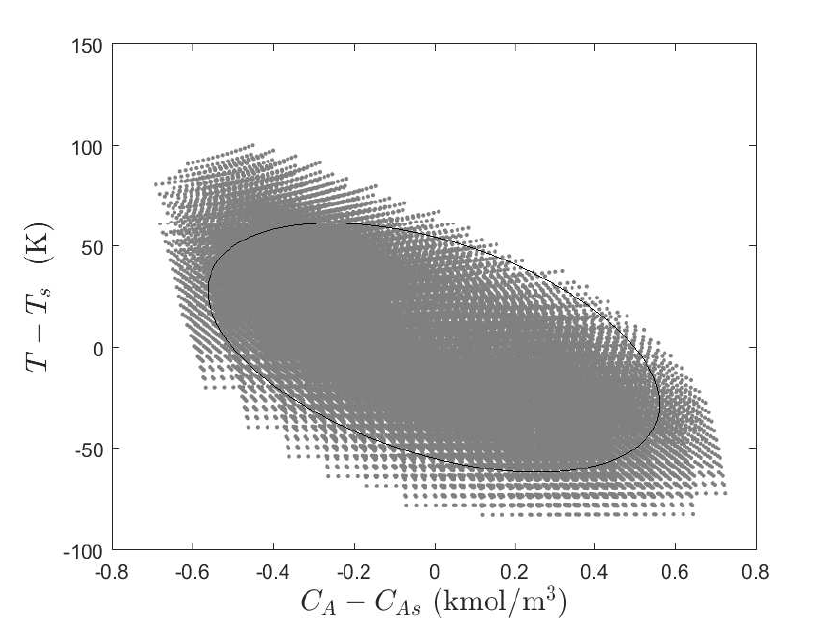
Figure 8. Final states after one sampling period when initialized in the stability region and for multiple inputs within the input bounds